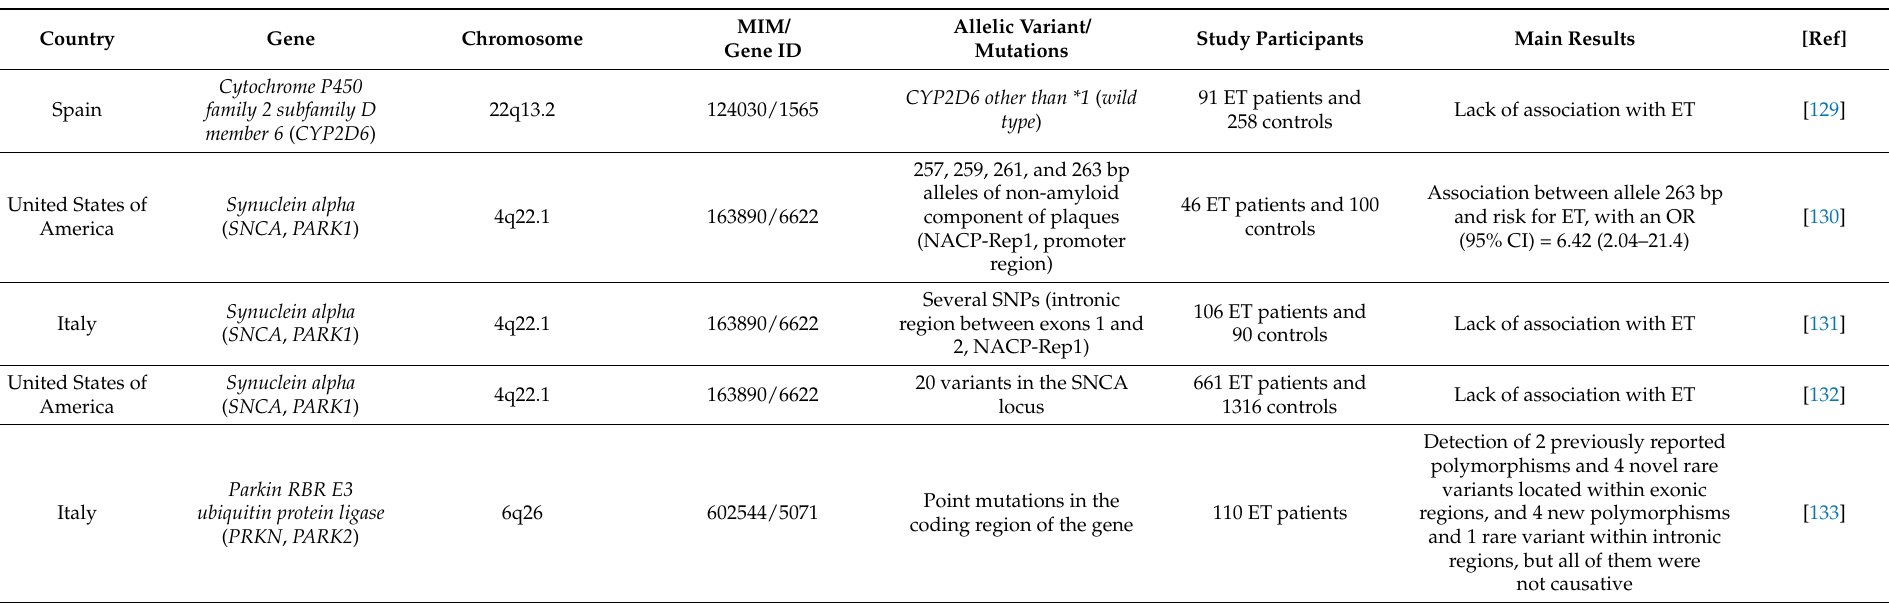
Table 2. Results of case-control association studies and case-only studies of possible candidate genes for